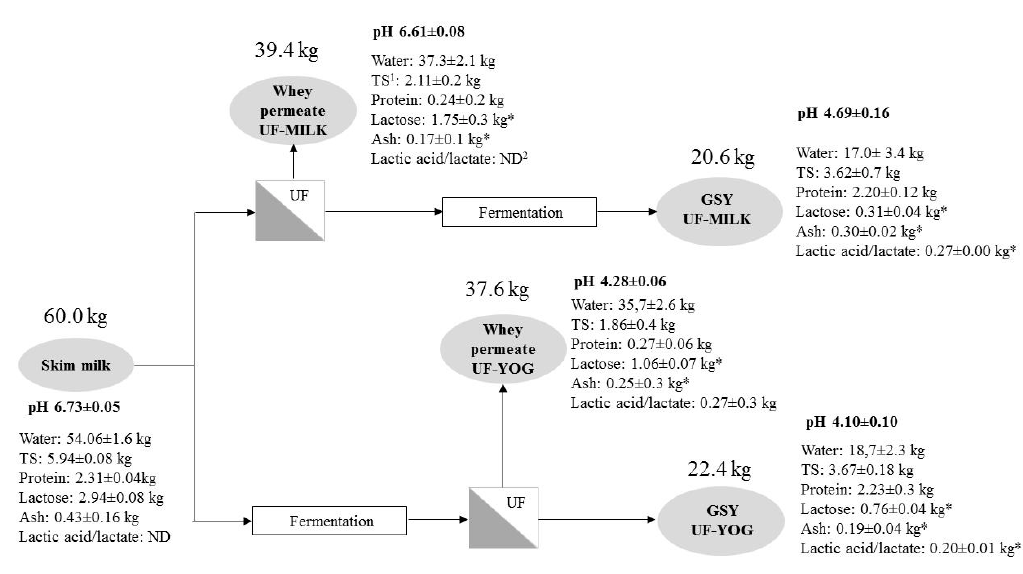
Figure 2. Average mass balance of milk components as influenced by GSY production method. 1 Total solid; 2 not detected; * significant difference ( p < 0.05) observed between both permeates or both retentates.